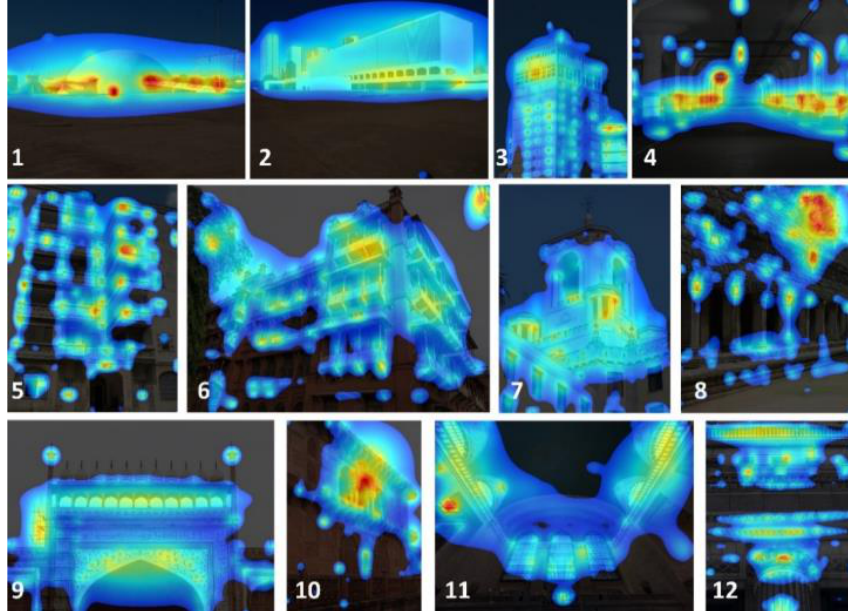
Figure 2. Heat maps produced individually by 3M-VAS from the images of Figure 1.